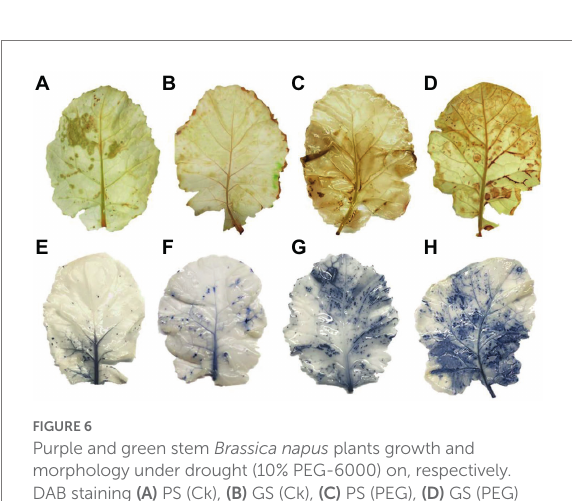
FIGURE 6 Purple and green stem Brassica napus plants growth and morphology under drought (10% PEG-6000) on, respectively. DAB staining (A) PS (Ck), (B) GS (Ck), (C) PS (PEG), (D) GS (PEG) and NBT staining, (E) PS (Ck), (F) GS (Ck), (G) PS (PEG), and (H) GS (PEG),